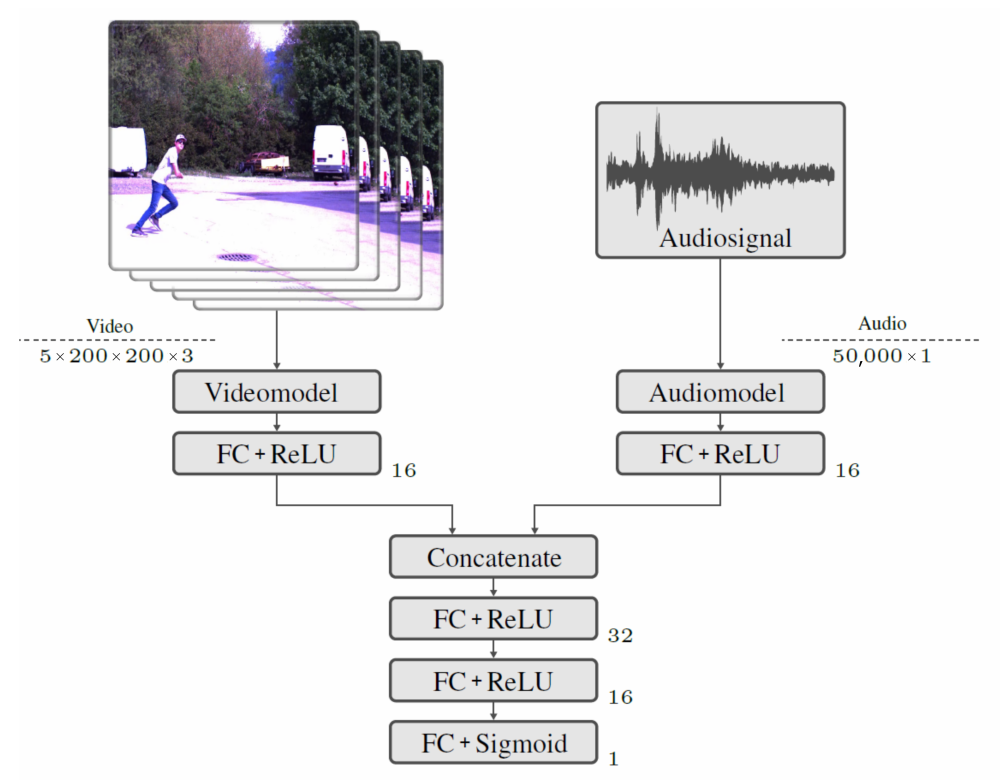
Figure 5. Network structure of the audio/video model with the applied operations. To the right of the operations, their set parameters can be seen, such as the number of neurons, filters and filter sizes. The size of the input tensor is shown per data type.